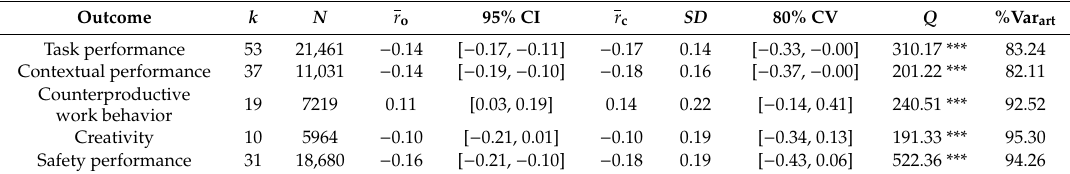
Table 2. Main e ff ects.